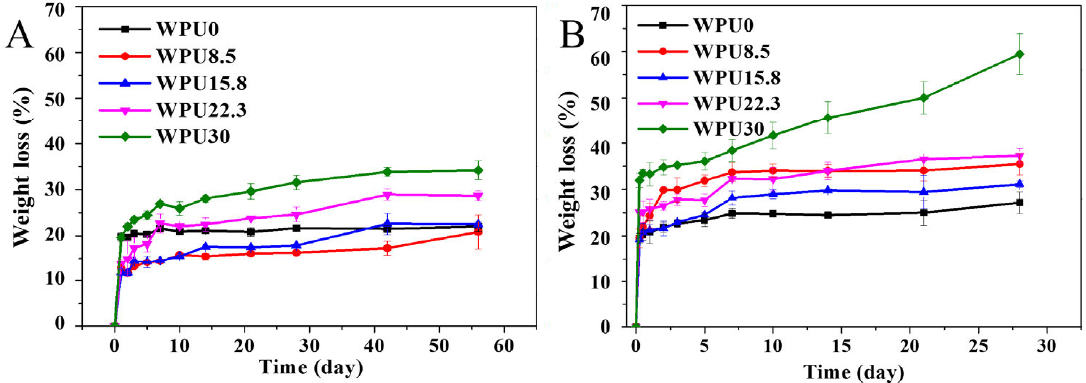
Figure 3. Weight loss profile of WPUn films under hydrolytic and enzymatic degradation. ( A ) Hydrolytic degradation in PBS; ( B ) Enzymatic degradation in PBS + lipase PS.